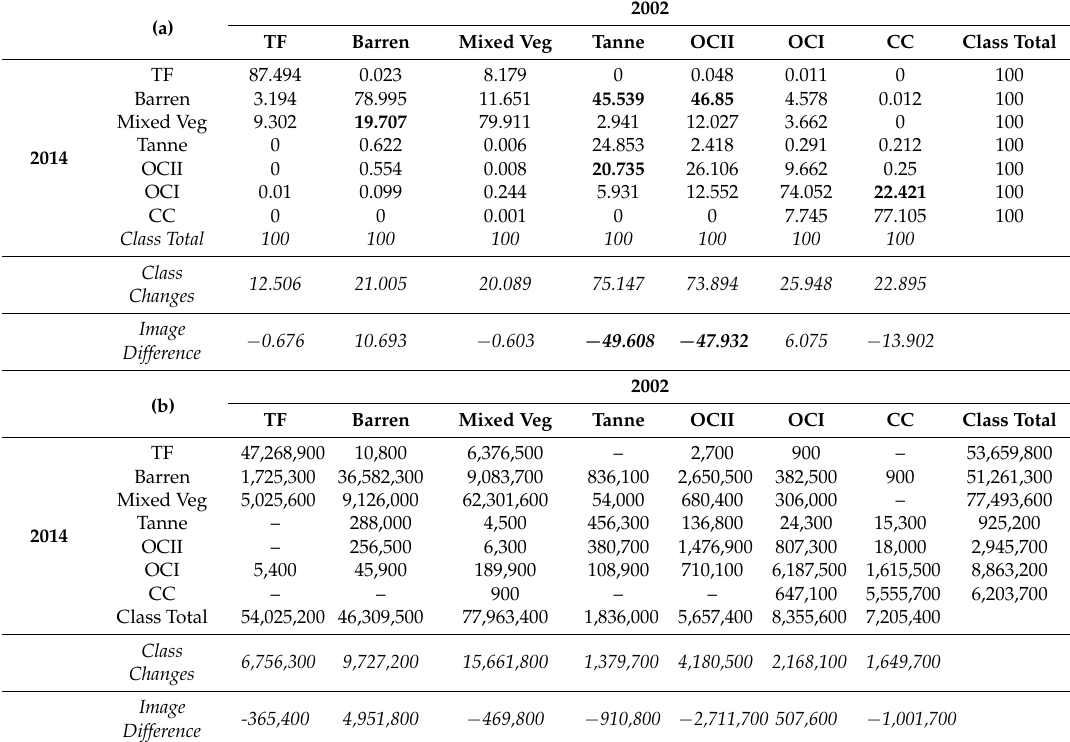
Table 7. Numeric summary of the class changes between the 2002 and 2014 Landsat classification. ( a ) shows percentage changes and ( b ) shows aerial changes in square meters. Highlighted cells indicate changes greater than 15%. OCII = open-canopy mangrove II; OCI = open-canopy mangrove I; CC = closed-canopy